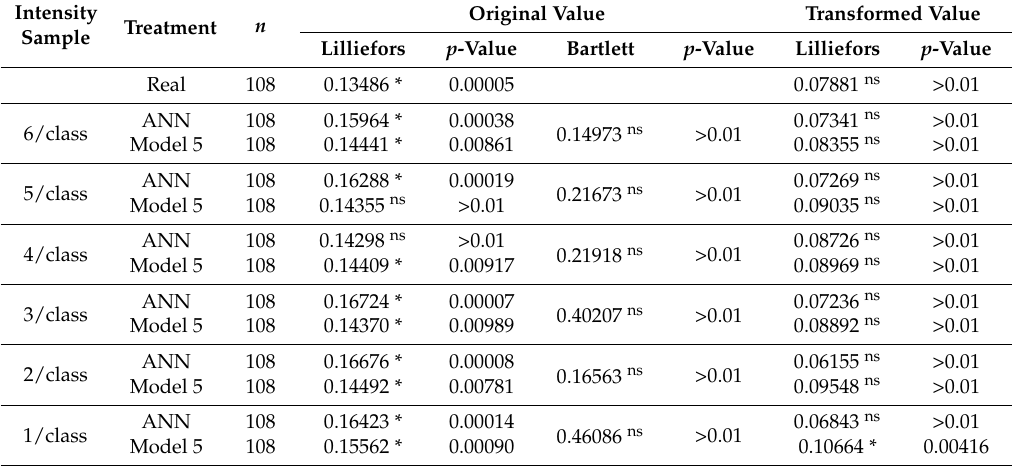
Table A3. Summary of the Lilliefors (normality) and Bartlett’s (homoscedasticity) tests for the real and predicted values in the different sample intensities of scenario